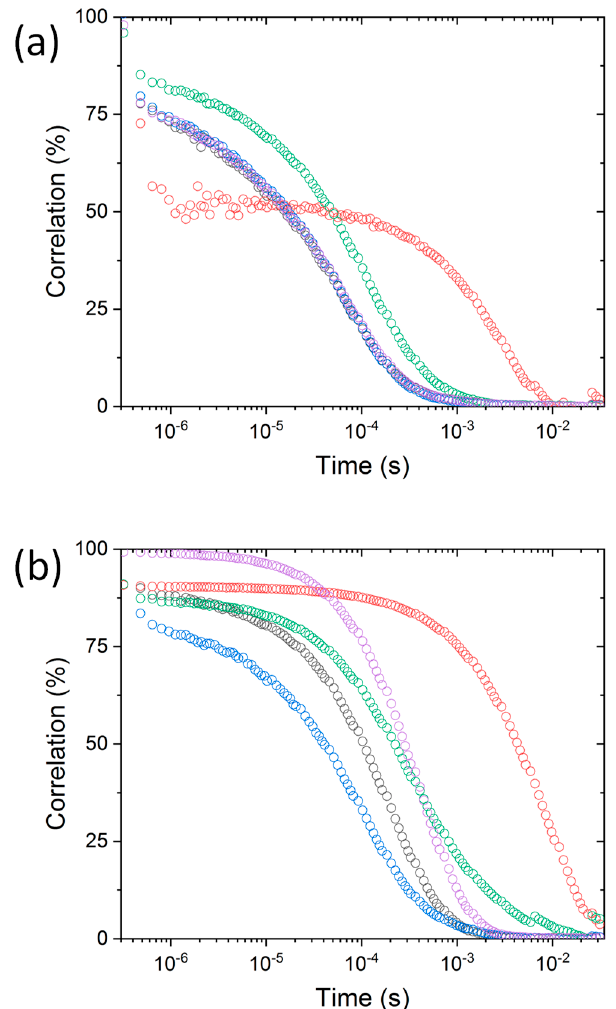
Figure 1. Dynamic light scattering curves from avidin-AuNP (red), β -lactoglobulin-AuNP (black), BSA-AuNP (blue), glucose oxidase-AuNP (green), peroxidase-AuNP (purple) at NaCl 10 mM ( a ) and 250 mM ( b ).